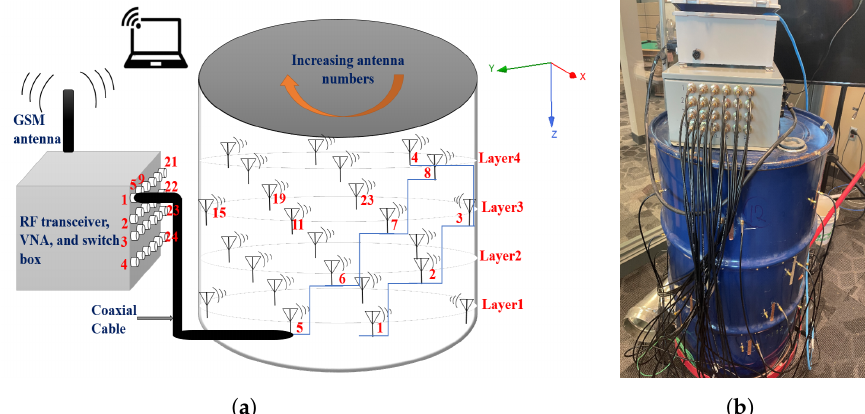
Figure 7. ( a ) block diagram and ( b ) real laboratory system used in microwave bin imaging.